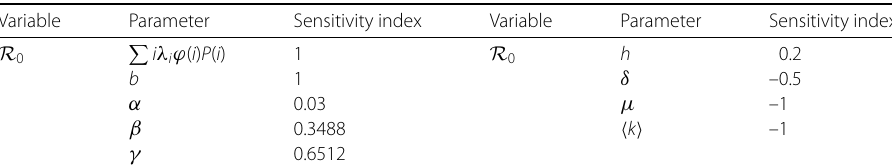
Table 2 Sensitivity index of R 0 for parameter values of model (1) Variable Parameter Sensitivity index